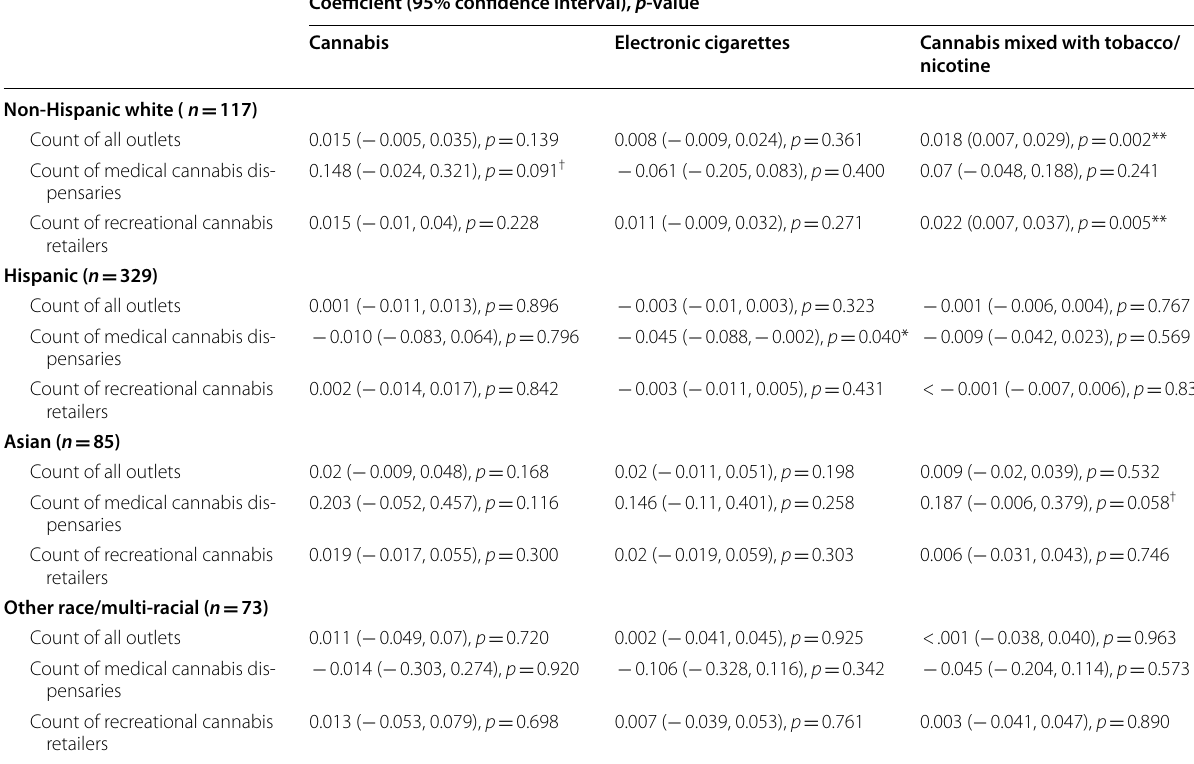
Table 3 Medical and recreational cannabis outlets within 5 mi and individual intentions to use, by young adults’